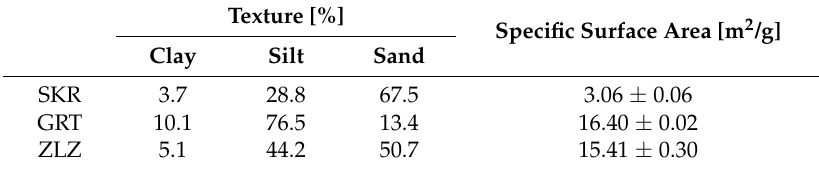
Table 1. Soil characteristics of silt loam (GRT) and two sandy loams (SKR and ZLZ).